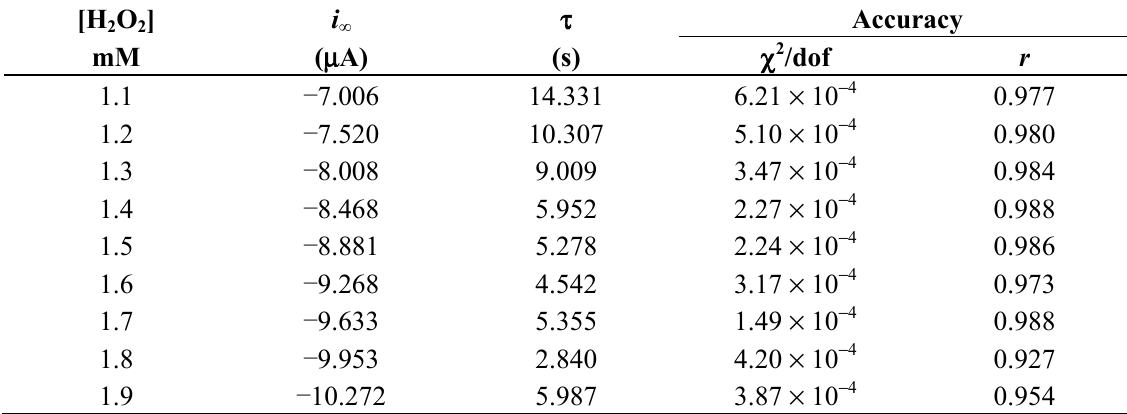
) and pre-steady-state relaxation time ( τ ) at different ∞